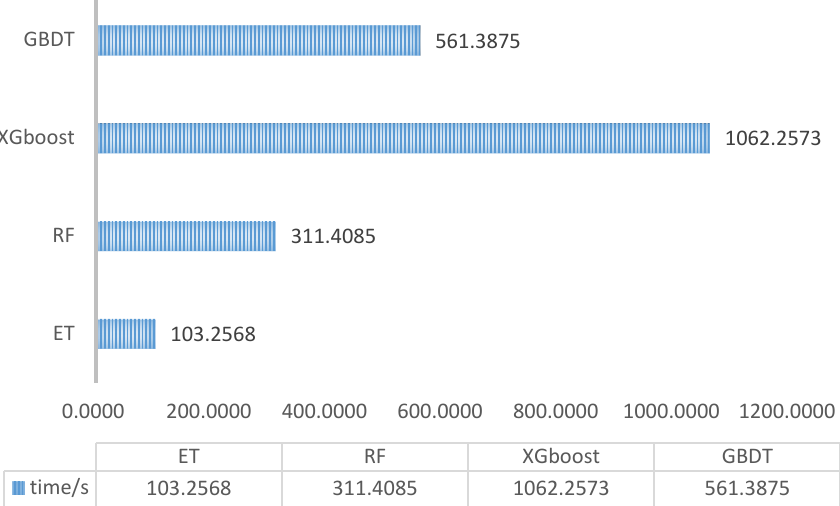
Figure 12. Algorithm model runtime.